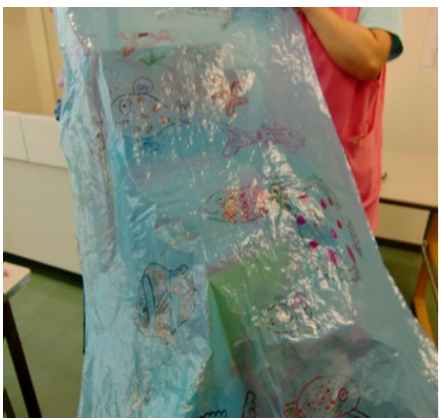
Figure 3. World of the sea (created using a plastic sheet).